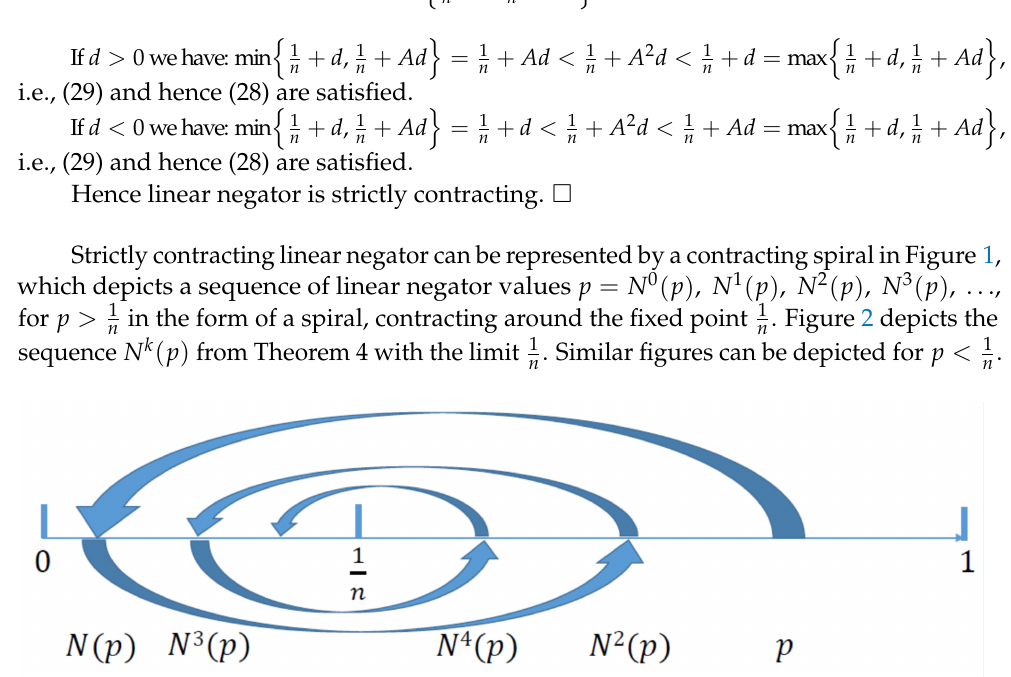
Figure 1. Contracting negator as a spiral contracting around the fixed point 1